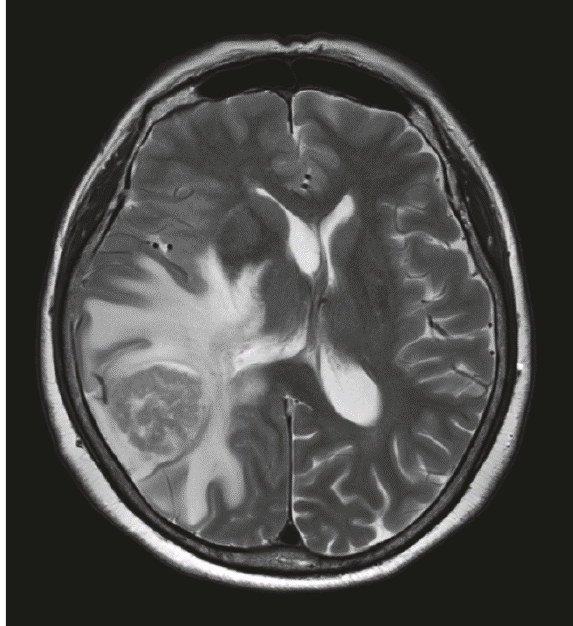
Figure 3: Axial T2-weighted brain MRI scan shows a solitary metastatic lesion in the right temporal lobe with brain